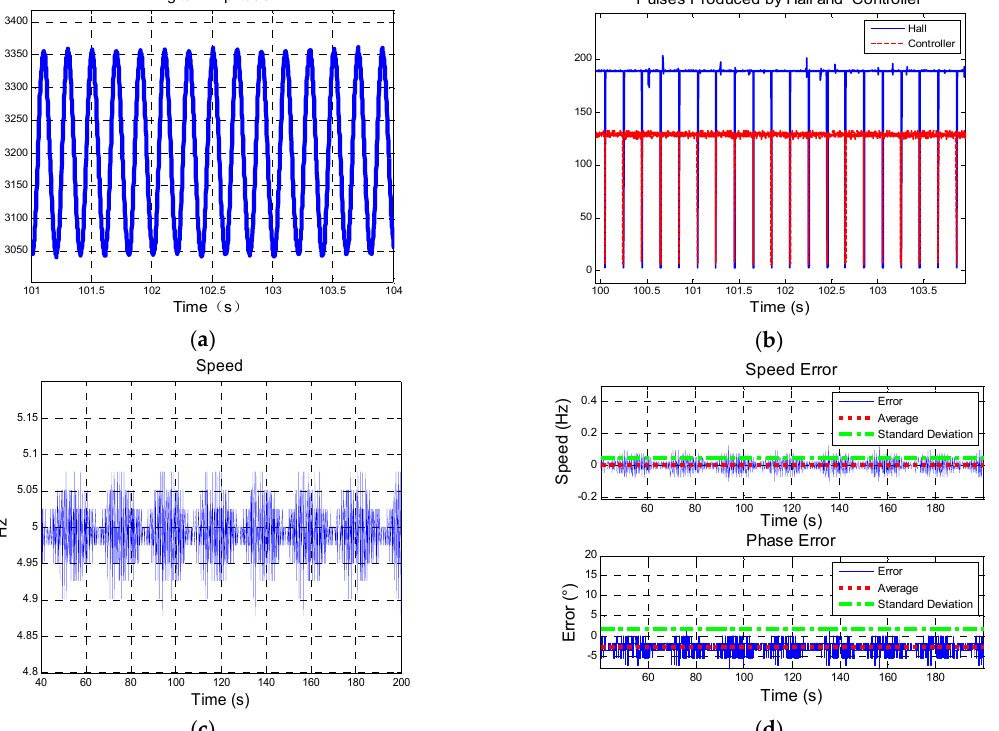
B ; ( b ) Comparison of pulses Z